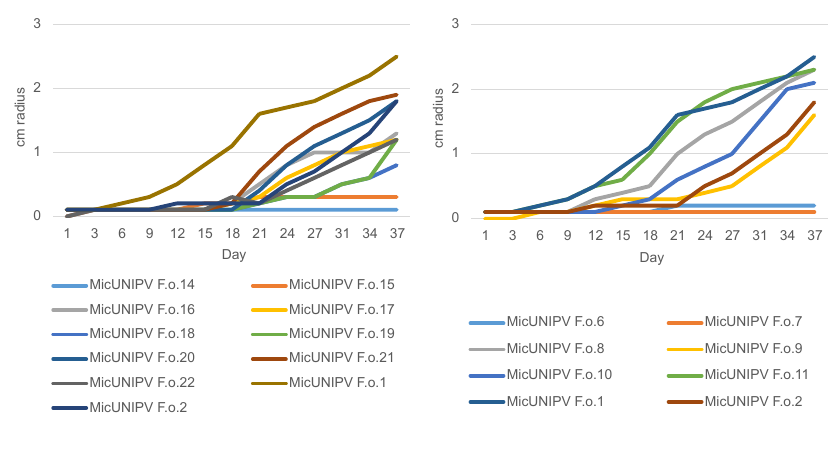
Figure 12 Growth curves of strains from Alpe Veglia (le) and Alpe Devero (right) on agar water.